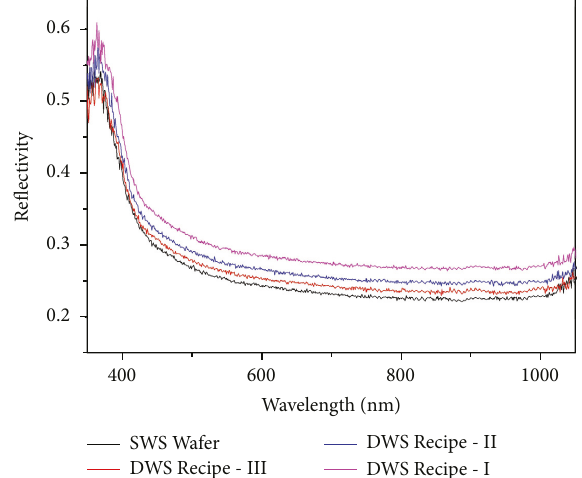
Figure 5: The light reflectivity spectrums of DWS-processed Si wafers, etched by using recipe-I, recipe-II, and recipe-III, and SWS- processed Si wafer, etched by using conventional acidic